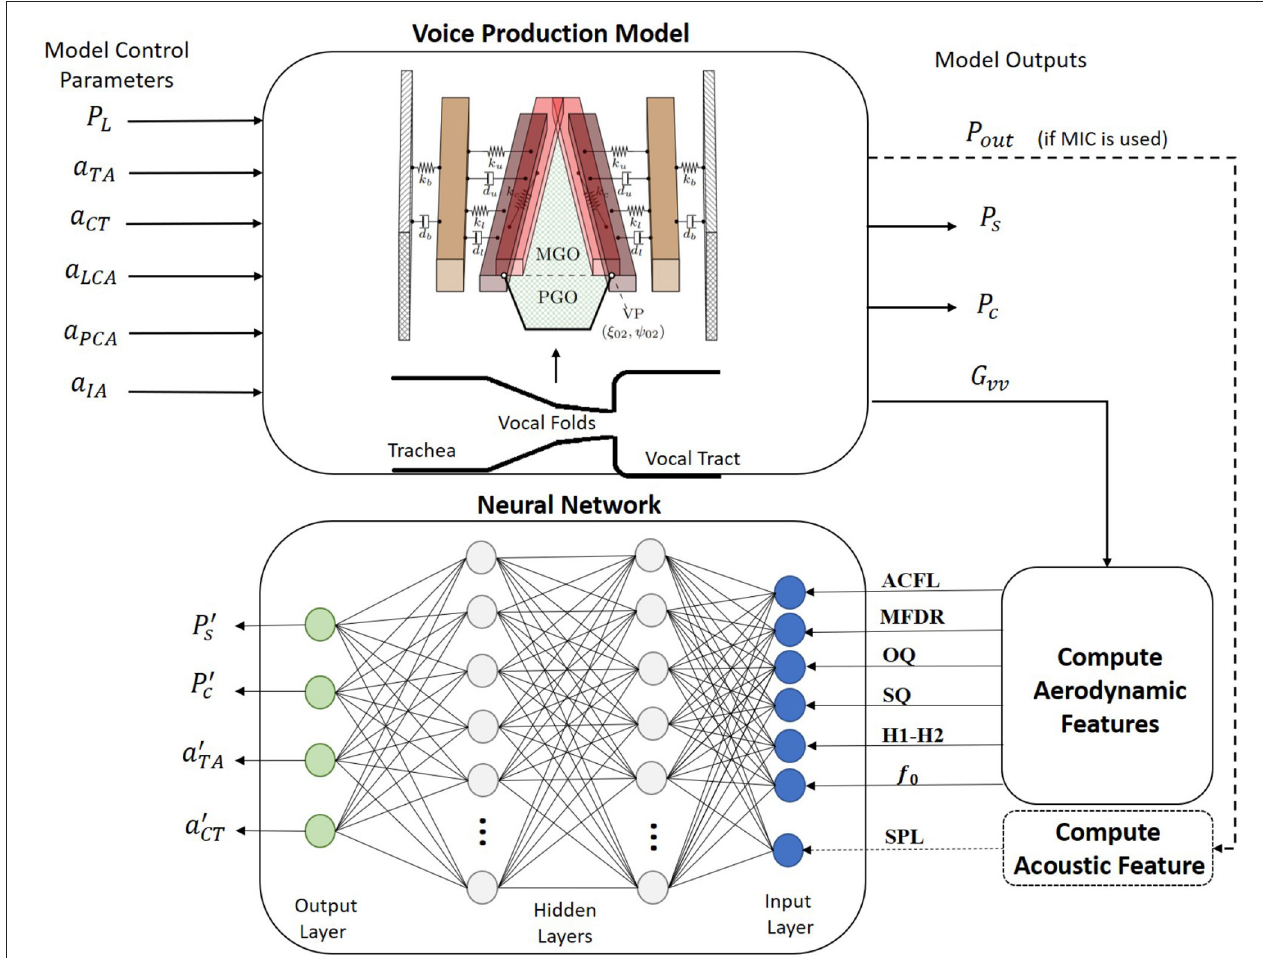
FIGURE 2 | A schematic for the proposed training procedure. A regression neural network is built for mapping accelerometer-based vocal features into clinically relevant estimates for subglottal pressure, subglottal collision pressure, and laryngeal muscle activation levels of the thyroarytenoid (TA) and cricothyroid (CT) muscles. Training data are produced from a numerical voice production